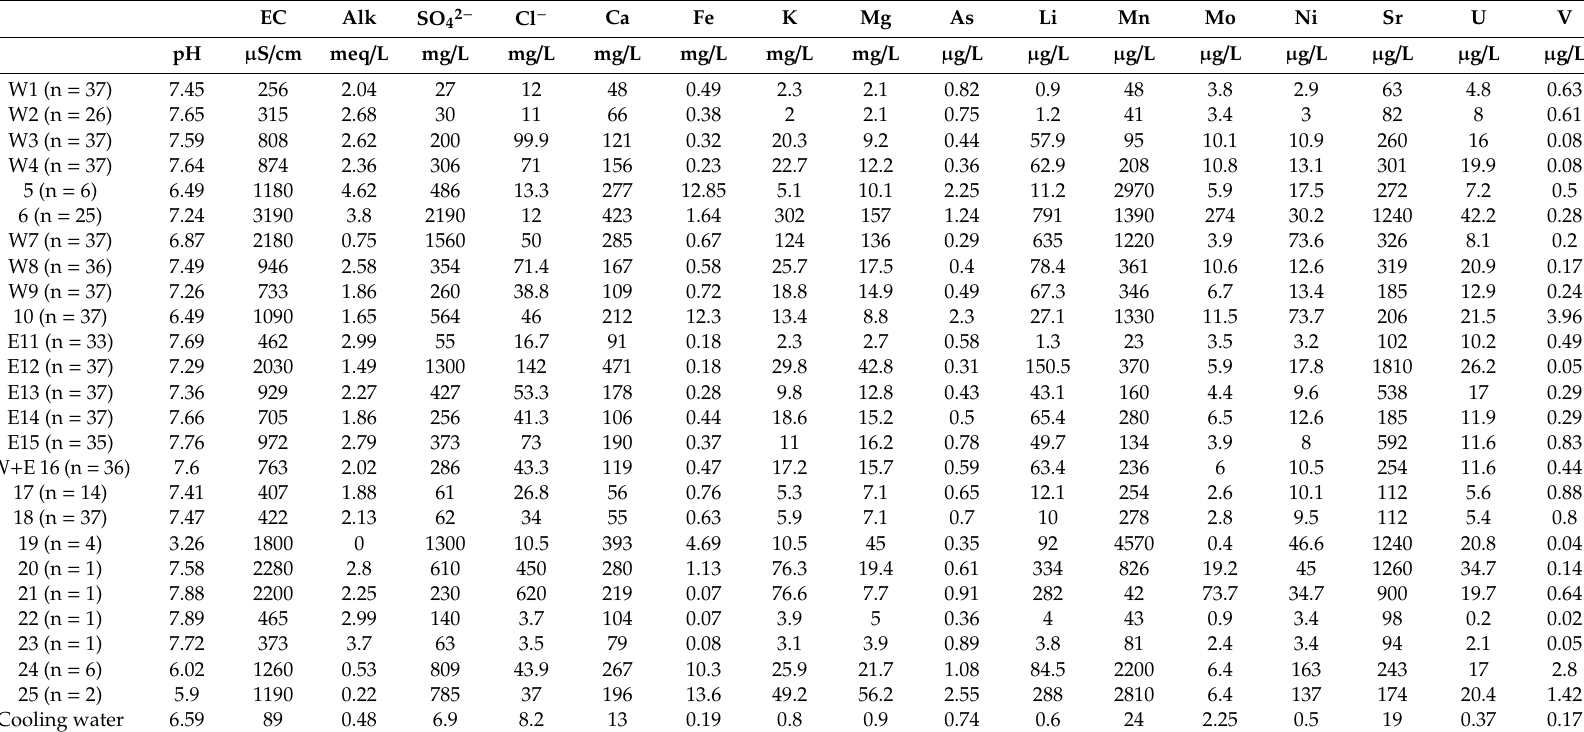
Table 3. Median pH, electrical conductivity, alkalinity, chloride, sulfate and element concentrations in surface